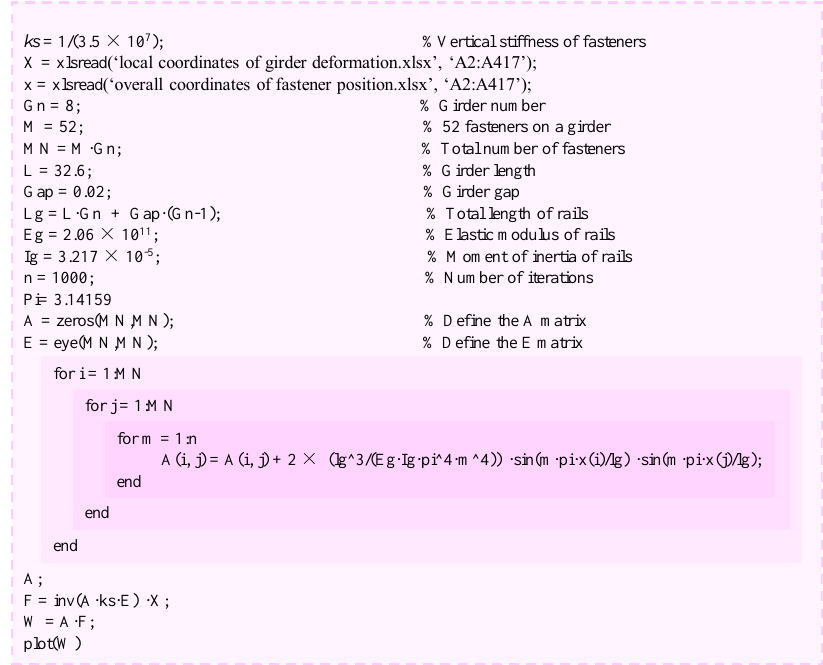
Figure 4. MATLAB flowchart and code for SAM and FAM.